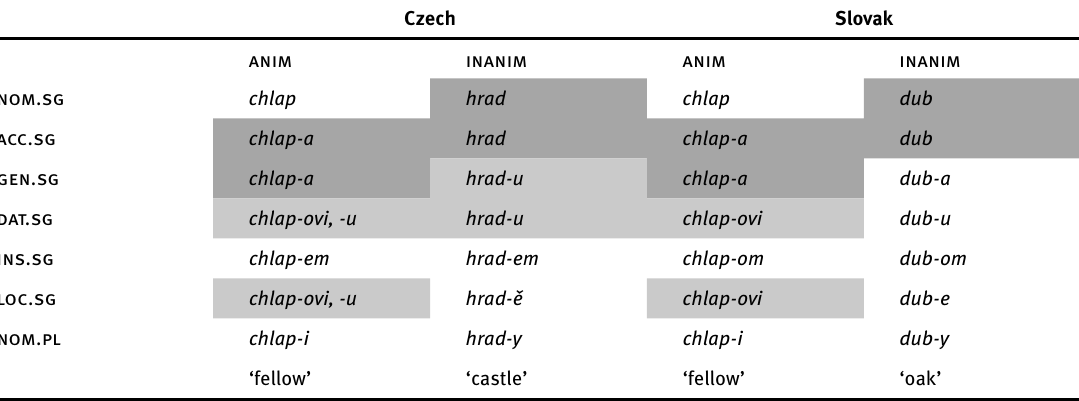
Table 6. Masculine paradigms in Czech and Slovak Czech Slovak anim inanim